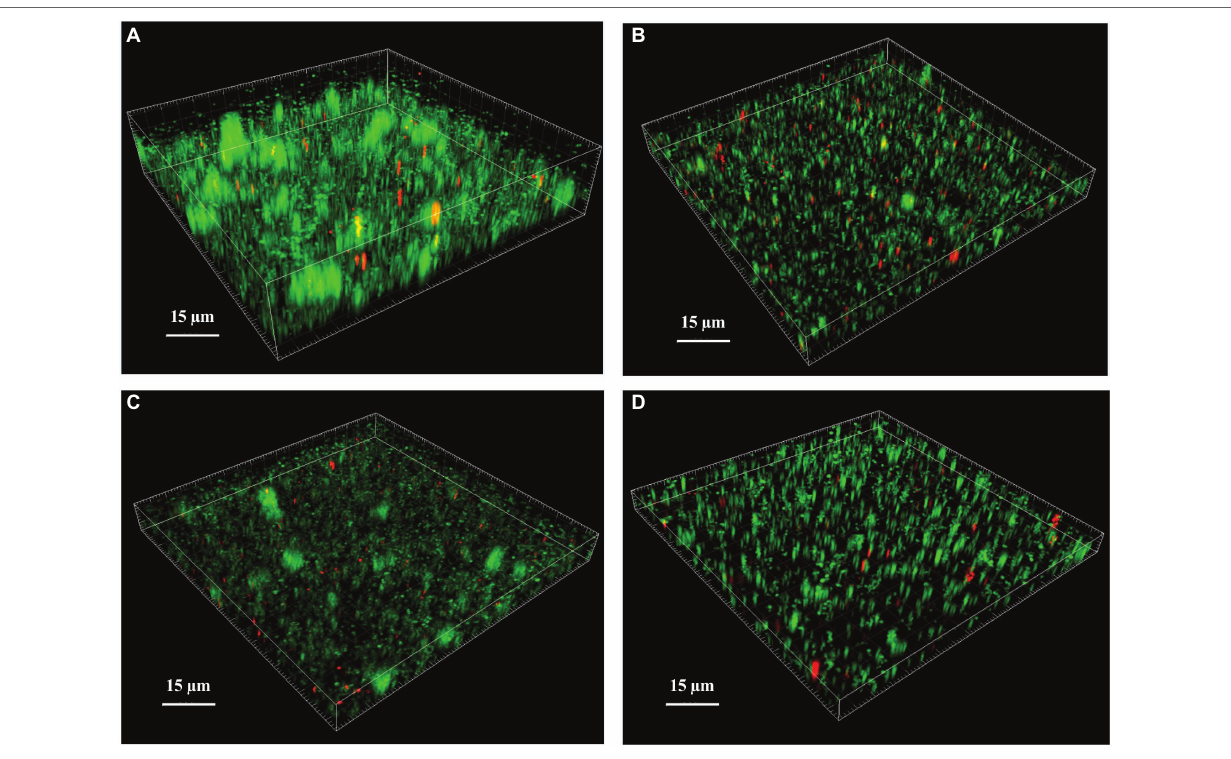
FIGURE 4 | Analysis of S. lugdunensis biofilm by confocal laser scanning microscopy (CLSM). The 24 h mature biofilms of (A) S. lugdunensis WT, (B) Δ lytSR , (C) Δ lytSR (pCU1: lytSR ), and (D) Δ lytSR (pCU1) were visualized after Live/Dead staining under CLSM. Live cells stained with SYTO®9 appear in green, while dead cells stained with propidium iodide are in red. Three-dimensional structural images were reconstructed, and the amount of fluorescence of viable and dead cells was determined using Imaris software. The figures represent one of three independent